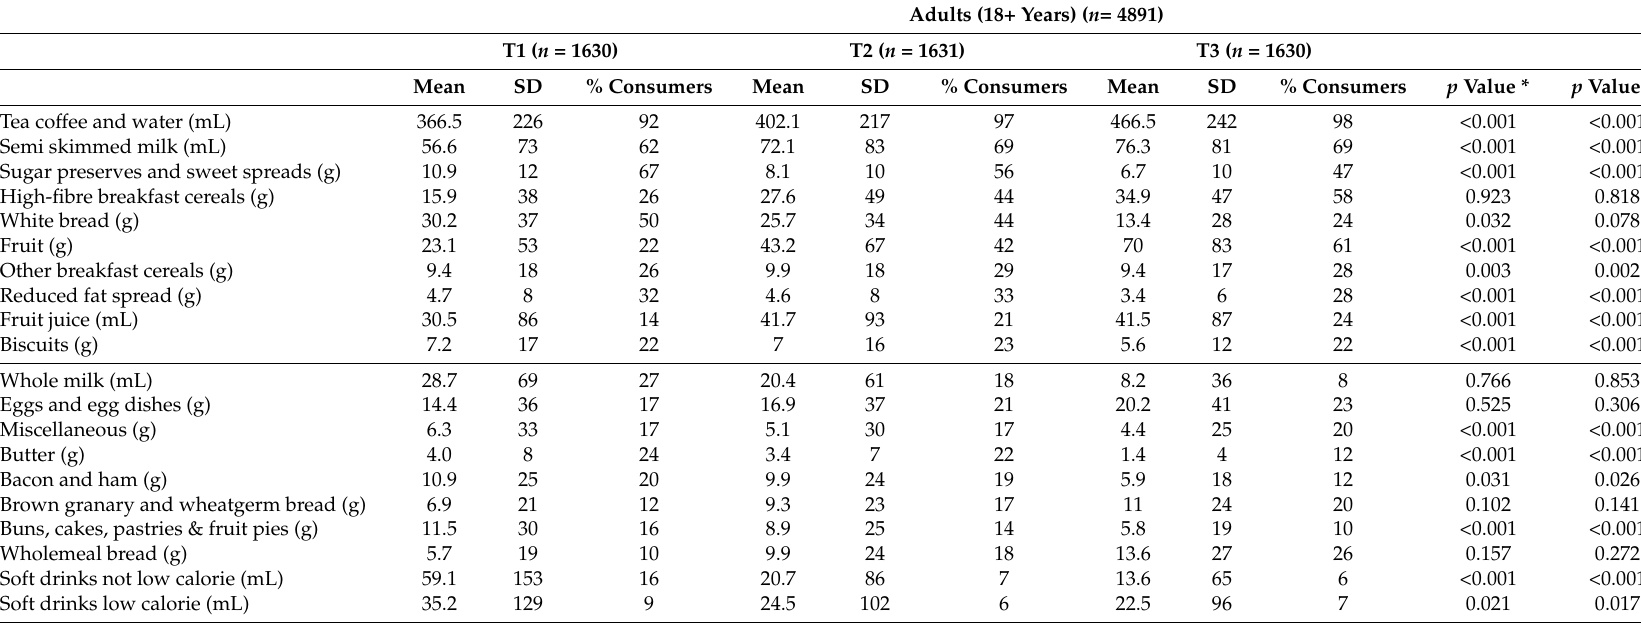
Table 6. Food intakes and % of consumers across tertiles of NRF 9.3 score in